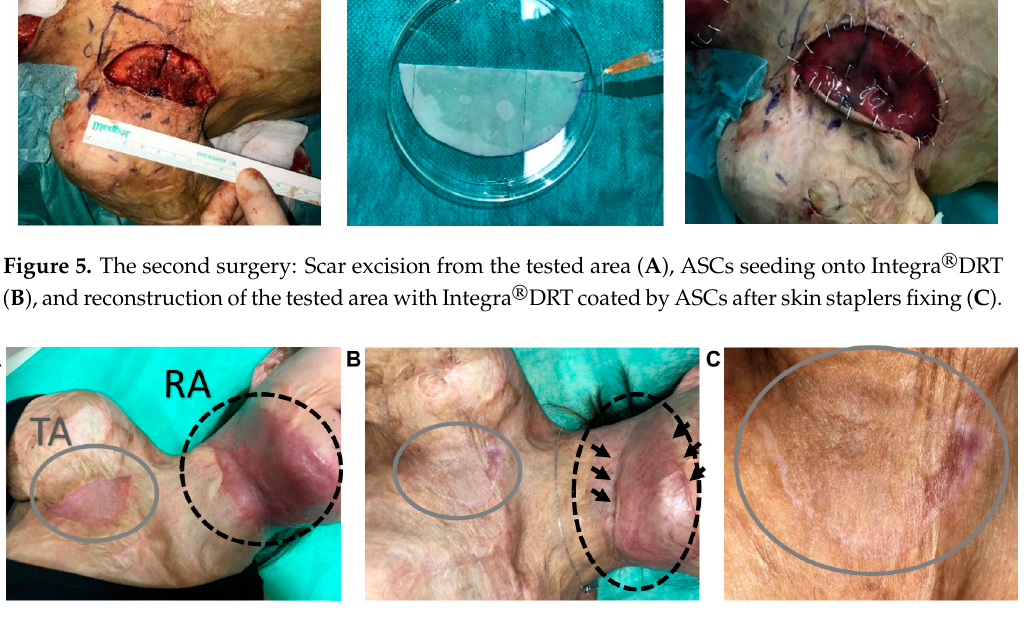
Figure 6. The visual assessment performed during a 4-week follow-up ( A ) and 9 months ( B , C ) after the last surgery. A enlargements of the tested area ( C ). TA, the tested area; RA, the reference area.